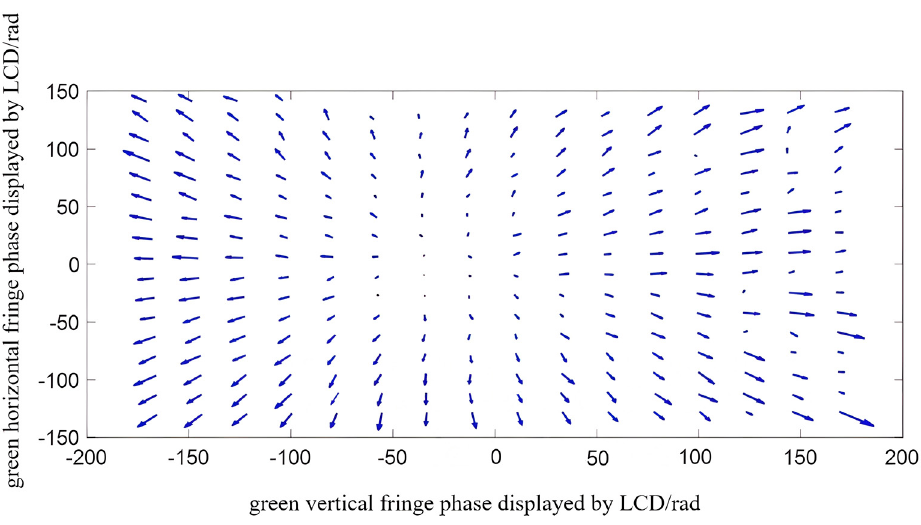
Figure 12. Schematic diagram of the chromatic aberration vector of the blue and green channels.